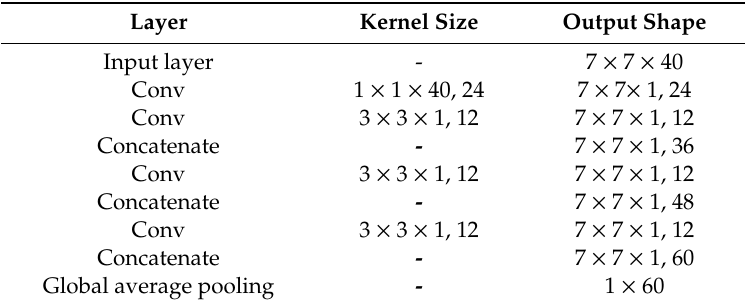
Table 5. Layer-wise summary of the 2D spatial